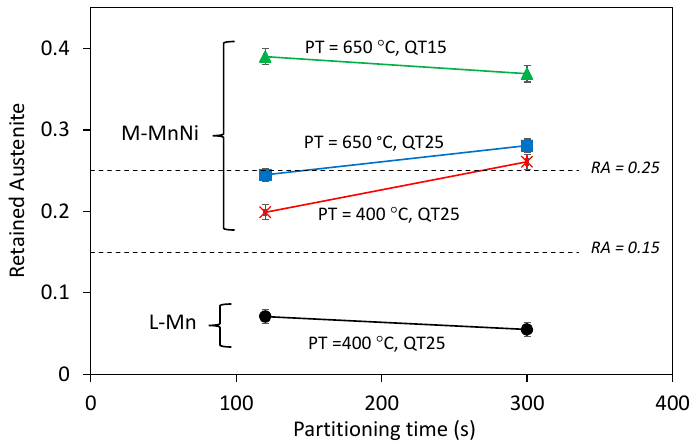
Figure 7. Retained austenite (RA) fraction as a function of partitioning time after Q&P treatments of L-Mn and M-MnNi steels with different partitioning temperatures (400 °C and 650 °C) and quenching temperatures (QT15 and QT25).